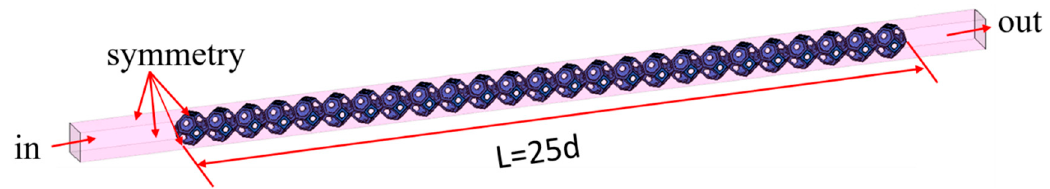
Figure 5. Computing domain of the simulation.